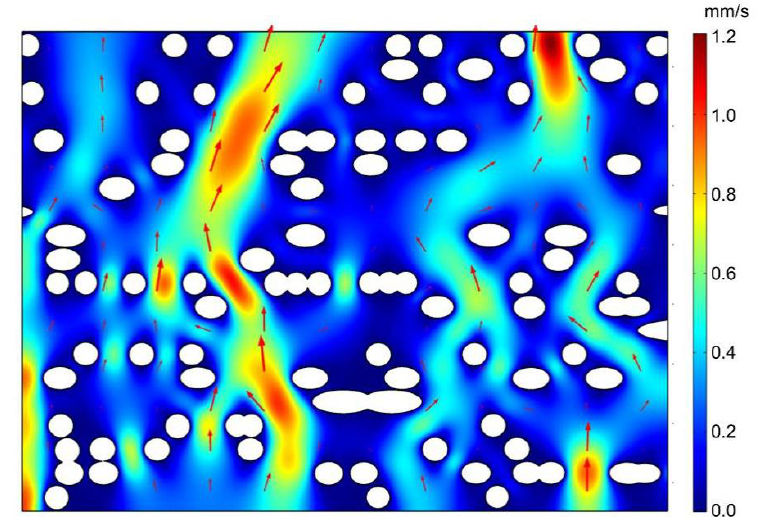
Figure 3. Flow velocity across intervessel pit membrane of angiosperm xylem from microfluid flow simulation. The fluid density was set to 998 kg / m 3 with a dynamic viscosity, µ , of 10 − 3 Pa s, corresponding to the properties of water at 20 °C. The pressure between the top and bottom surface was 1000 Pa in this example. White circles represent cellulose microfibril. Red region represents faster flow rate while blue region represents slower flow rate. Arrows represent velocity vector.